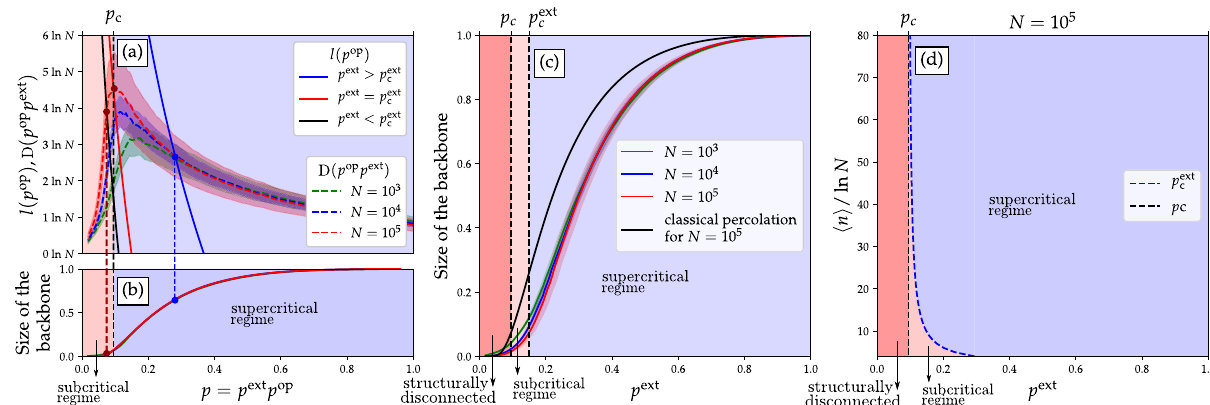
Fig. 5 Robustness of a quantum Barabási-Albert network. Exploration of bond percolation on a quantum Barabási-Albert network with N nodes and average degree c = 6 where the number of entangled pairs in each link follow an exponential distribution with mean 〈 n 〉 . We simulated the the Bollobás variant of the Barabási-Albert model 49 where we generated one Barabási-Albert network for each value of N . The diameter of the network D ( p ) was then determined by removing link from the network with probability 1 − p ext , based on 100 runs for each value of p . We plot the operational distance l op ( p op ) and the network diameter D ( p ) versus the probability that links are both operational and not removed p = p op p ext for h n i ¼ ð 10ln ð N ÞÞ α with α = 1 in a with the large colored dots indicating their intersection. Labelled are the curves Labelled are the curves l op ( p op ) for p ext ¼ p ext which correspond to the smallest c value of p indicating a stable l op ( p op ) = D ( p op p ext ) solution. The intersection between two nodes at p 0 , is marked by blue dots for solutions in the supercritical regime, and red dots in the subcritical regime. Next the size of the backbone (number of nodes in the backbone) is plotted as a function of p in b . For each intersection point found in a there is a corresponding size in b . In c the size of the backbone is plotted as a function of the probability that links are not removed p ext . The functionally supercritical regime is represented as the blue region while the functionally subcritical regime is shown as the light red region. The dark red region on the other hand represents the structural subcritical region for a network of size N = 10 5 . We immediately observe that no discontinuous phase transition is seen (unlike in the Erd ő s-Rényi case). Finally in d we depict the phase diagrams of h n i = ln N versus y for N = 10 5 nodes including the curves for the critical probabilities p ext c and p c . Shaded region around each curve represents the standard deviation of the